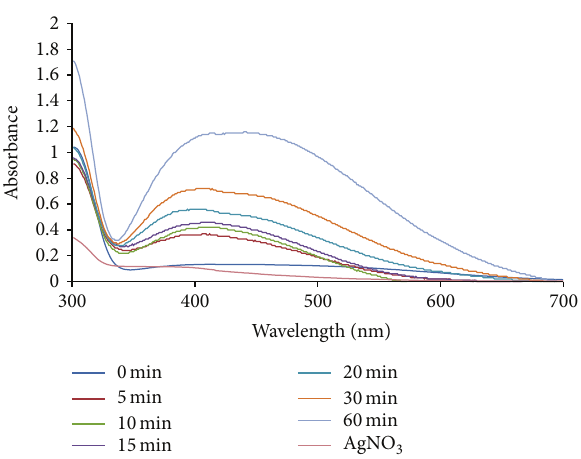
Figure 4: UV-vis spectra of AgNPs measured at different time intervals.